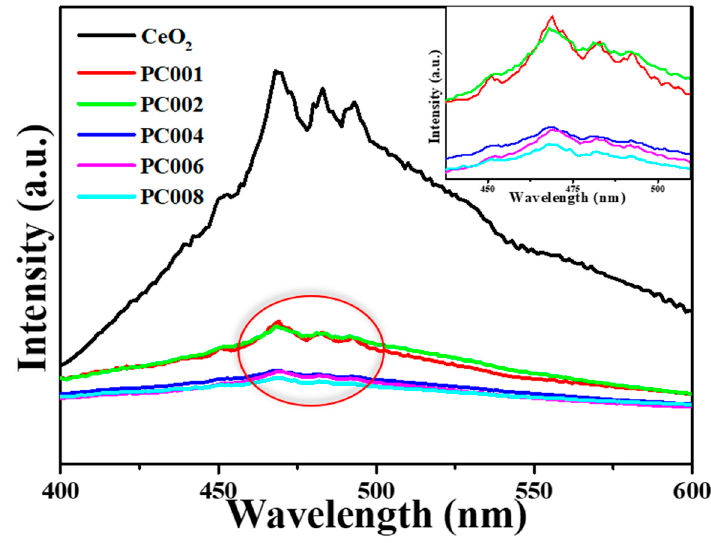
Figure 6. PL spectrum of the CeO 2 / PANI powders as a function of the amount of PANI coating.